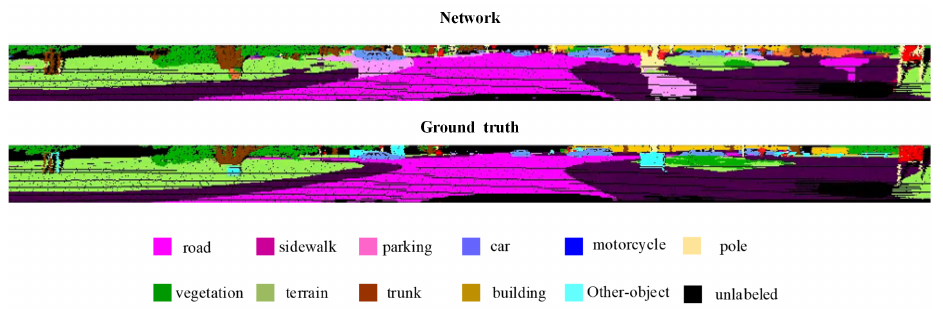
Figure 3. An inference result of the proposed segmentation network.